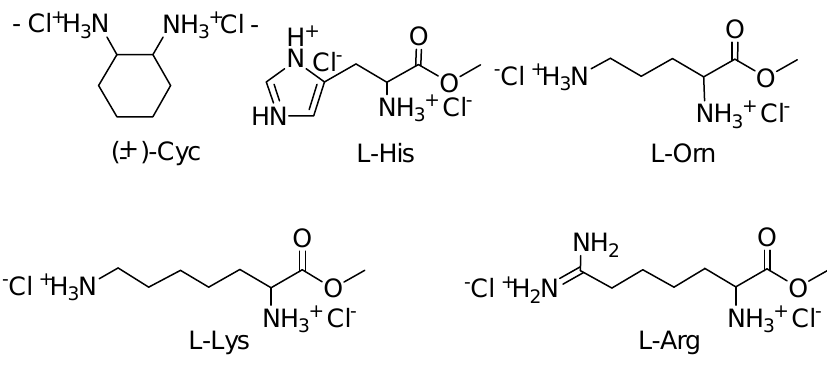
Figure 2 . Investigated chiral guest